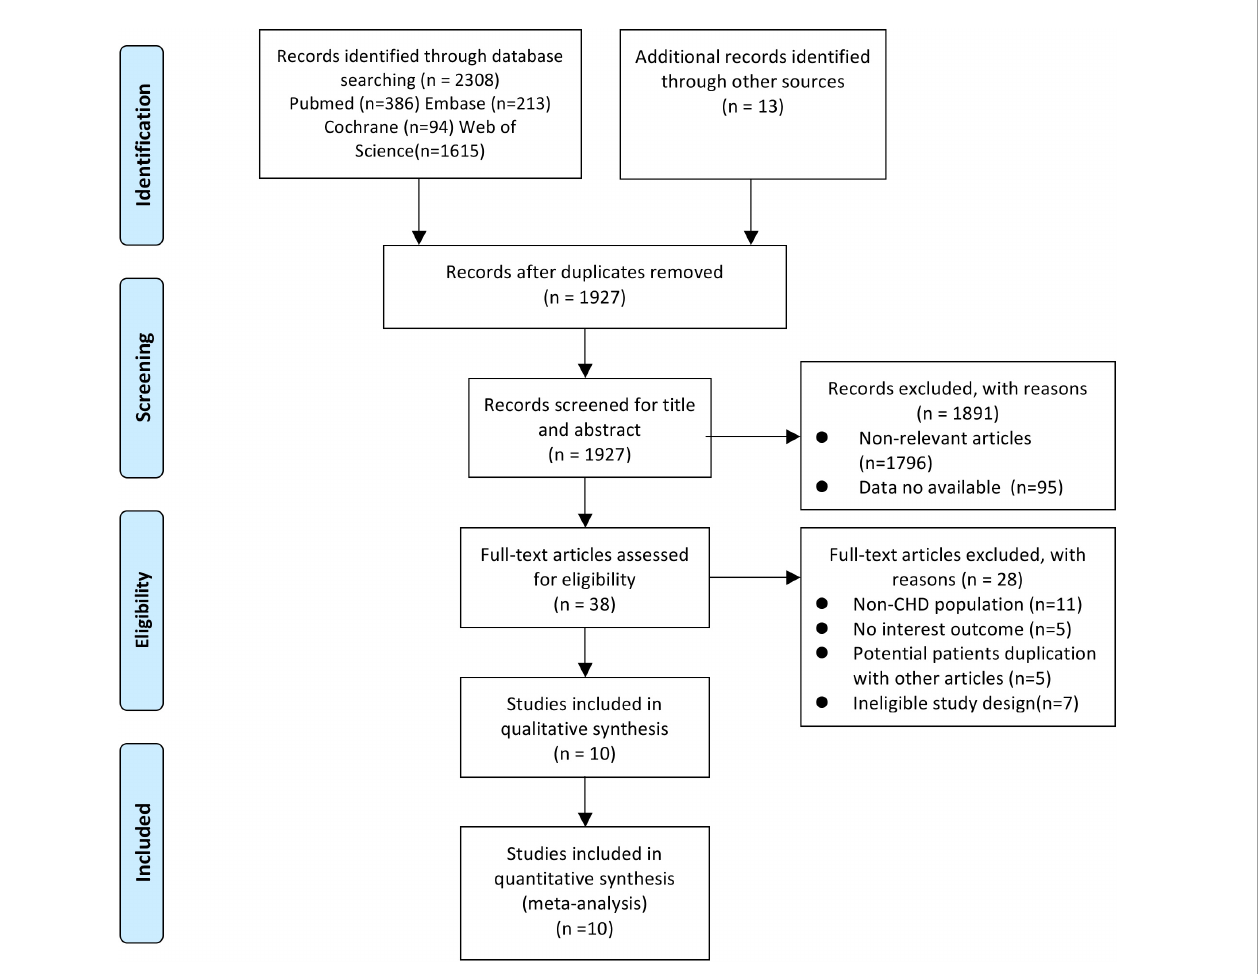
FIGURE1 Flow diagram of the study search and selection process. From Moher et al.